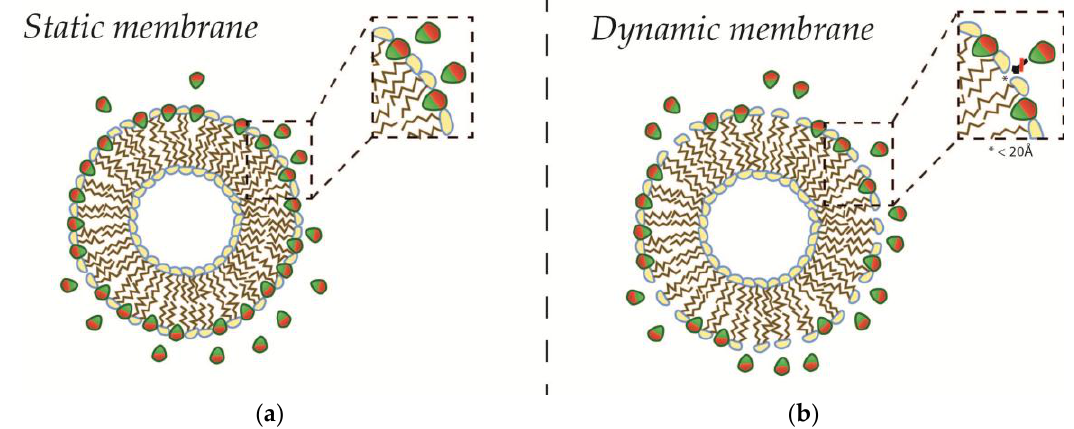
Figure 5. Saturating binding of amphiphiles to static or dynamic membranes. Liposome is shown here with an excess of amphiphiles ( red / green ). Inset shows the complete saturation of any putative lipid packing defects on static membranes ( a ), and incomplete saturation with small excess defects below the permissive size for insertion (here 20 Å ) on dynamic membranes ( b ).